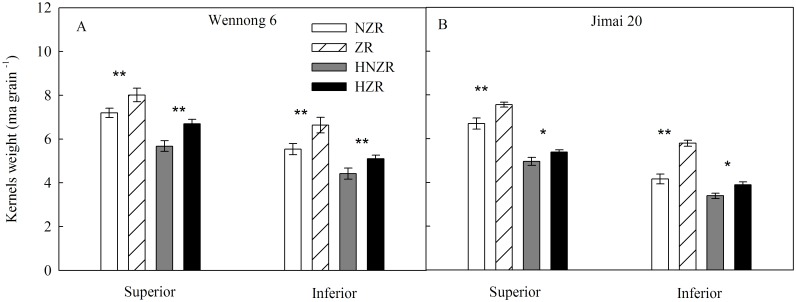
Effects of high temperature and exogenous ZR on kernels weight at 10 days after anthesis.NZR and ZR represent detached spike culture without and with ZR under 25/20°C condition, respectively. HNZR and HZR represent detached spike culture without and with ZR under 35/20°C condition, respectively. Vertical bars represent ± standard error of the mean (n = 9) where they exceed the size of the symbol. *, ** denote significant difference at P < 0.05, P < 0.01, respectively.